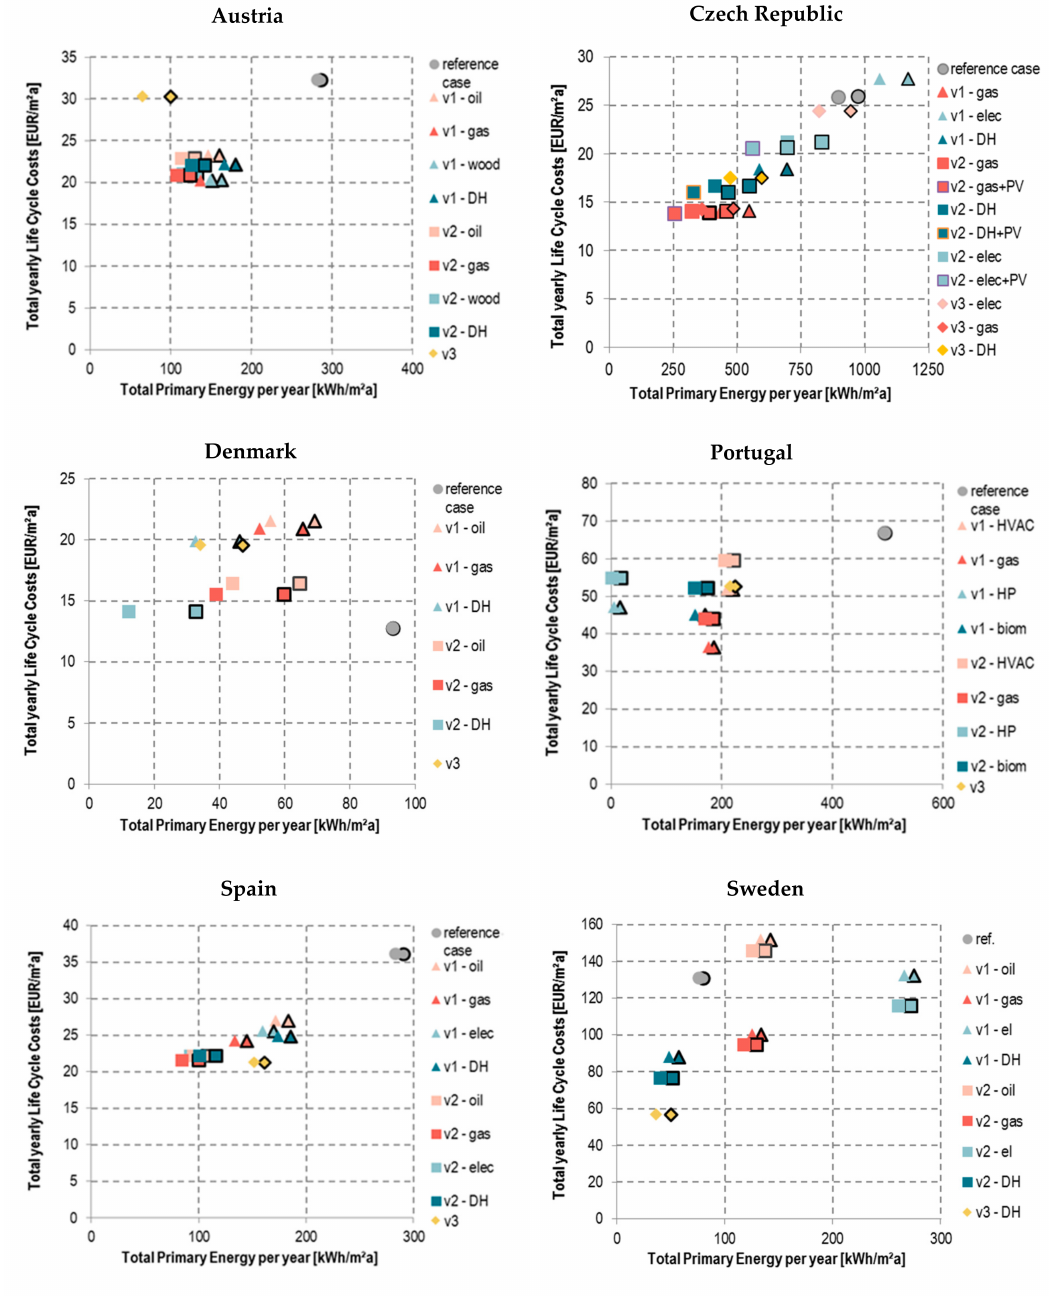
Figure 6. Comparison of calculations for total primary energy for the six case studies, without including embodied primary energy and with embodied primary energy (marked with a black outline) for the different renovation